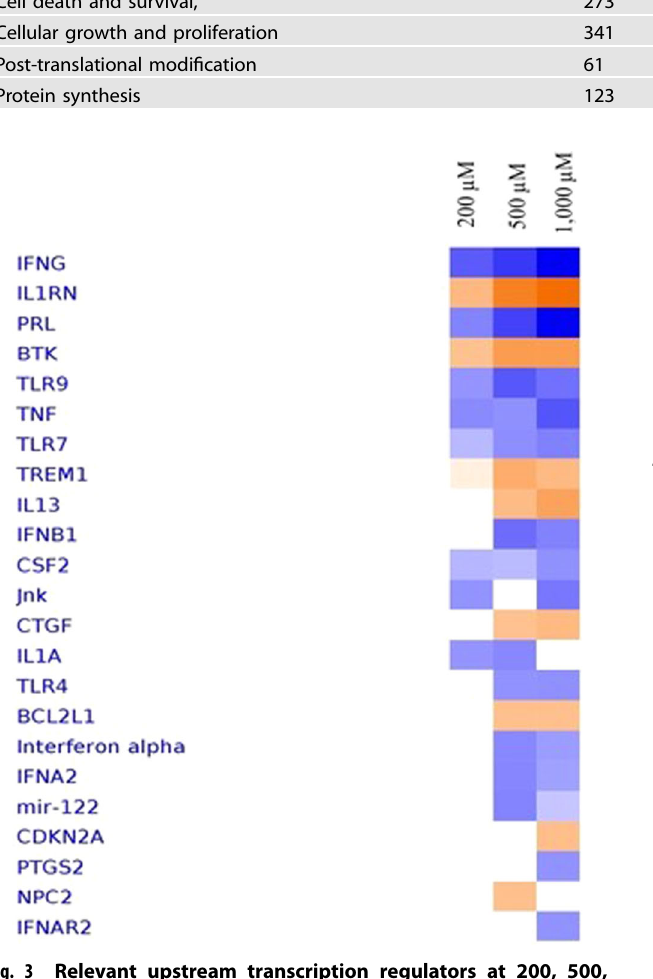
Fig. 3 Relevant upstream transcription regulators at 200, 500, and 1000 μ M of ASA treatments. Most activated or inhibited upstream transcription regulators as estimated by the z -score for each comparison from Ingenuity Pathway Analysis. Orange denotes predicted activation and blue predicted inhibition.